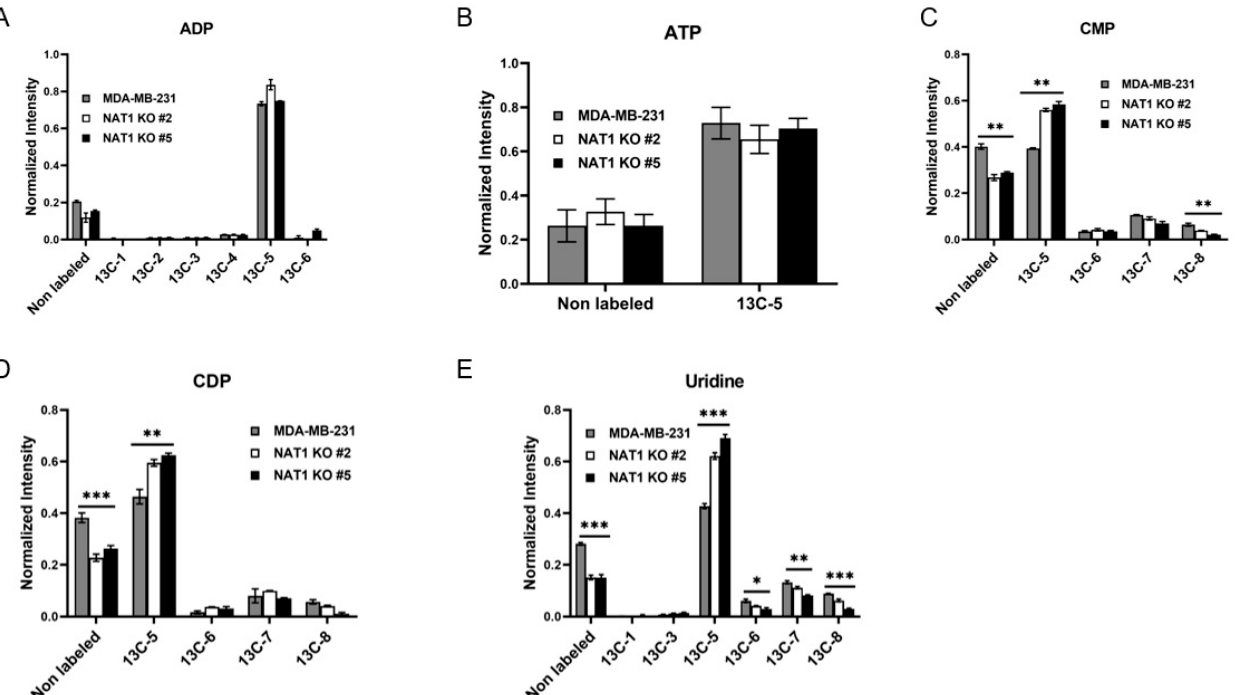
Figure 6. N -Acetyltransferase 1 Knockout Effect on Nucleotides in MDA-MB-231 Cells. Carbon- 13 enrichment of nucleotides were measured in MDA-MB-231 cells and NAT1 KO #2 and #5 after 24 h incubation with [ 13 C]-glucose. Data are presented for both unlabeled [ 12 C] and detected [ 13 C]-labeled metabolites. ( A ) ADP ( 13 C-1,-2,-3,-4,-5,- and 6) ( B ) ATP ( 13 C-5) ( C ) CMP ( 13 C-5,-6,-7, and -8) ( D ) CDP ( 13 C-5,-6,-7, and -8) ( E ) Uridine ( 13 C-1,-3,-5,-6,-7, and -8). Data represent the average of at least three experiments ± SEM, * q < 0.05, ** q < 0.01, and *** q < 0.001 compared to MDA-MB-231.